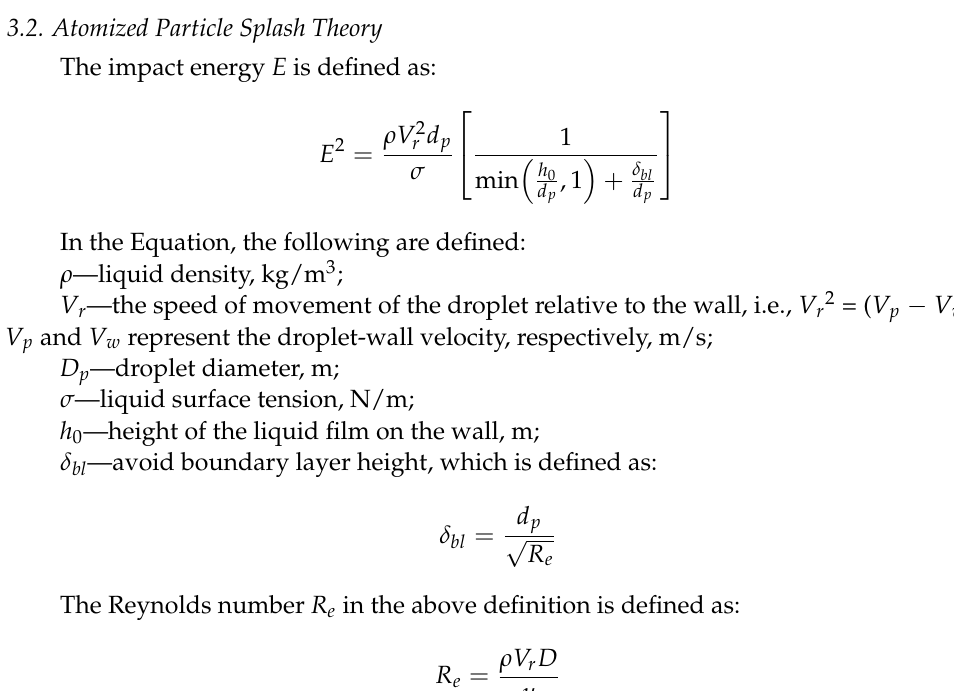
Figure 7. Schematic diagram of painting principle (with cover).